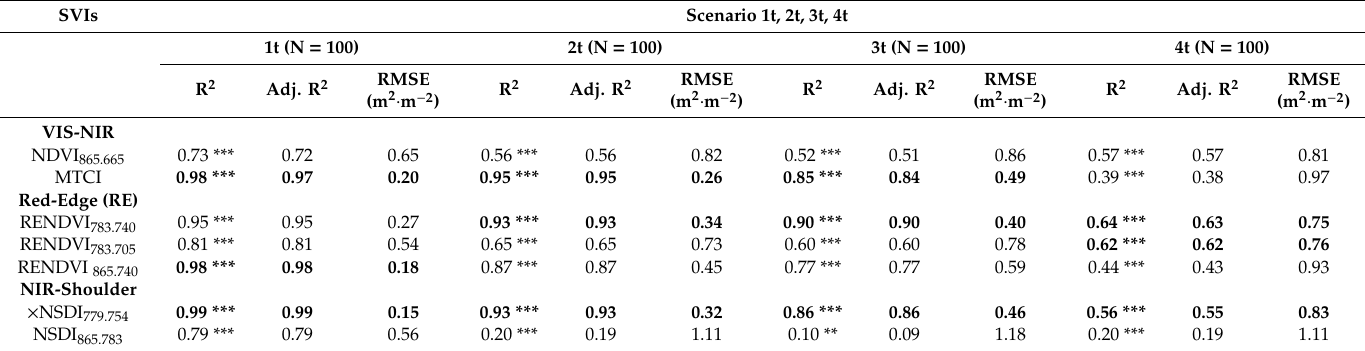
Table 6. Summary of the statistics (N, number of observations; R 2 , coe ffi cient of determination; Adj. R 2 , adjusted coe ffi cient of determination; RMSE, root mean square the spectral vegetation indices (SVIs) calculated from PROSAIL simulated spectra by scenarios considering spatial scale LAI ranges (1t–4t) described in Section 2.3.4. The three best-fitting models are highlighted in bold. Asterisk indicates significance of correlation: *** p < 0.001; ** p < 0.01; * p < 0.05. n.s., not significant (Pearson’s correlation test).